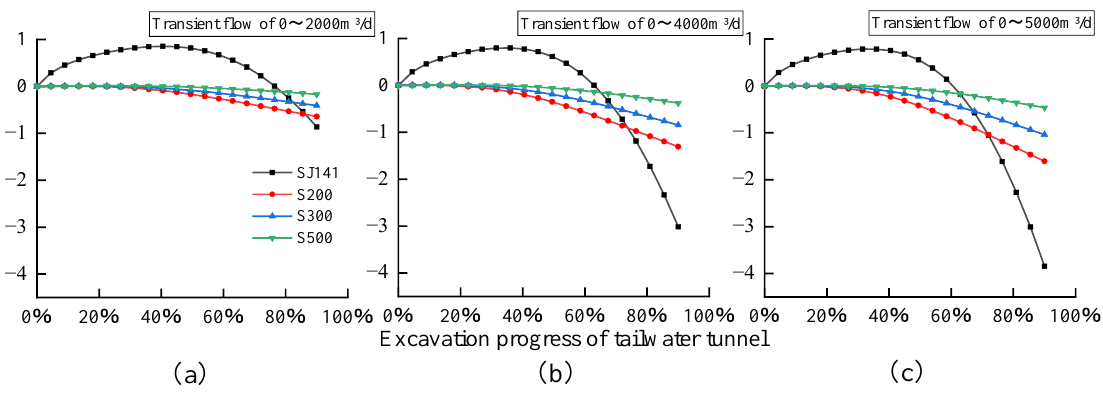
Figure 13. Variations in the water level at different distances under limiting seepage conditions. (( a ) is change in water level of the maximum water inflow of 2000 m³/d, ( b ) is change in water level of the maximum water inflow of 4000 m³/d, ( c ) is change in water level of the maximum water inflow of 5000 m³/d)